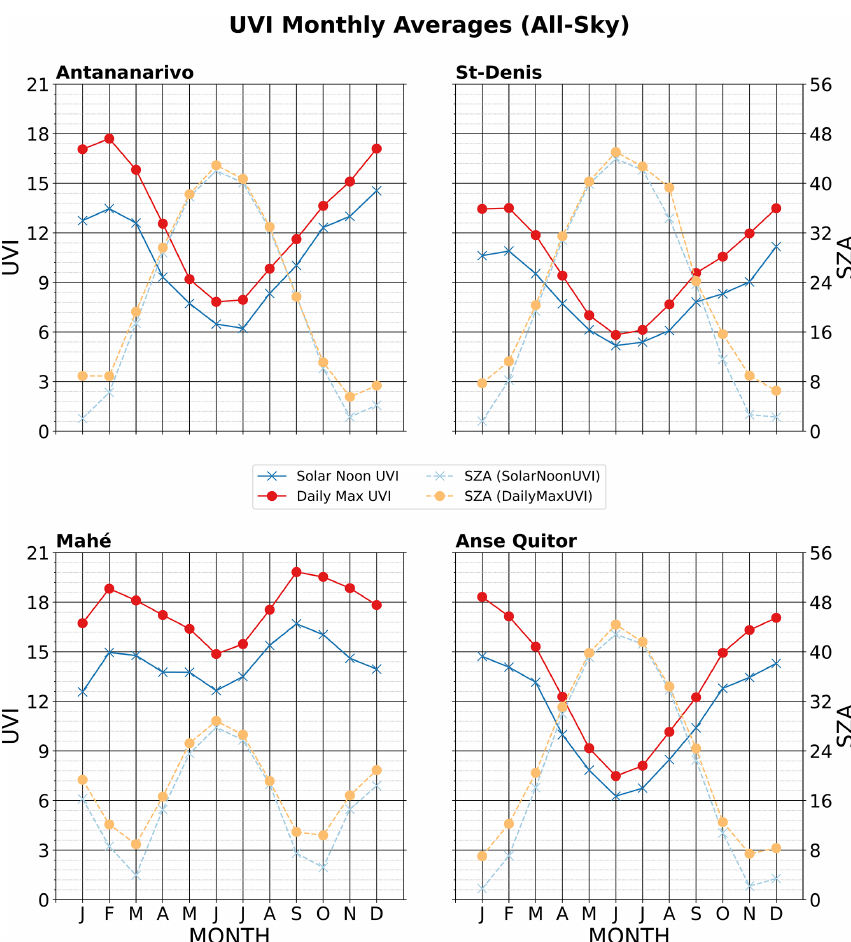
Figure 6. UVI monthly averages in all-sky conditions for the four stations of Antananarivo, Saint-Denis, Mahé, and Anse Quitor. The monthly averages of the daily max UVI is represented by the red line with filled circles. The corresponding SZA is represented by the dotted orange line. The monthly averages of the UVI at solar noon is represented by the blue line with blue crosses. The corresponding SZA is represented by the dashed blue